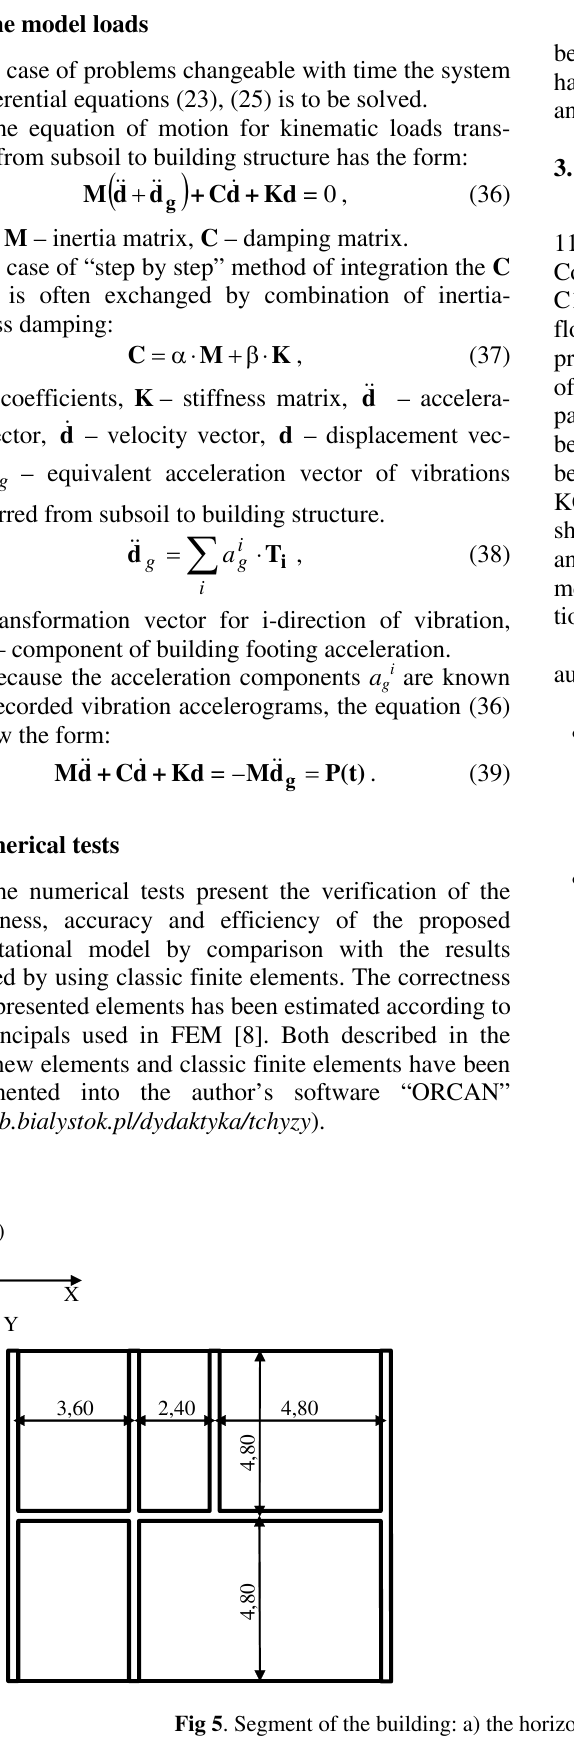
Fig 5 . Segment of the building: a) the horizontal projection, b) computer